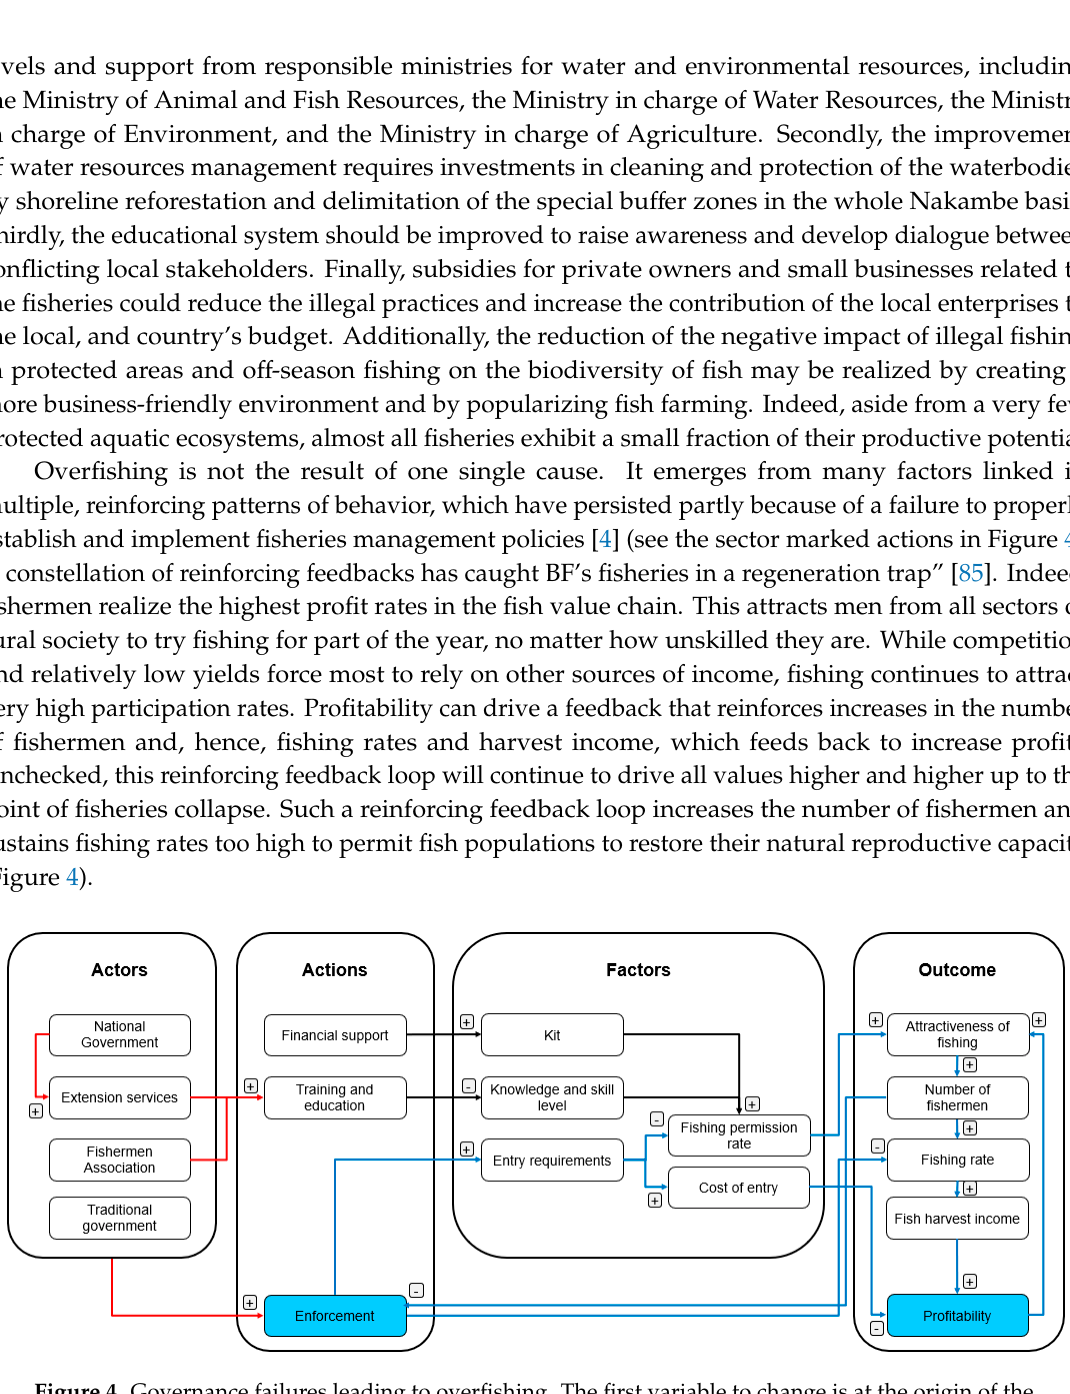
Figure 4. Governance failures leading to overfishing. The first variable to change is at the origin of the arrow, then the variable at the receiving end of the arrow will respond with a change. Regarding the “polarity”, “ + ” shows that an increase or decrease in the first variable is matched by the same change in the receiving variable, “-“ shows that the variables change in opposite directions. Actors: stakeholders for enforcement; actions: current measures; factors: elements that potentially could be provided by enforcement, training, and financial support to improve fishing governance; red arrows: interactions that are not established but could help make fisheries sustainable if instituted and established as standard parts of governance; blue arrows: feedback loops; outcome: potential results in terms of profitability; kit: fishermen’ equipment. Source: modified after Sendzimir